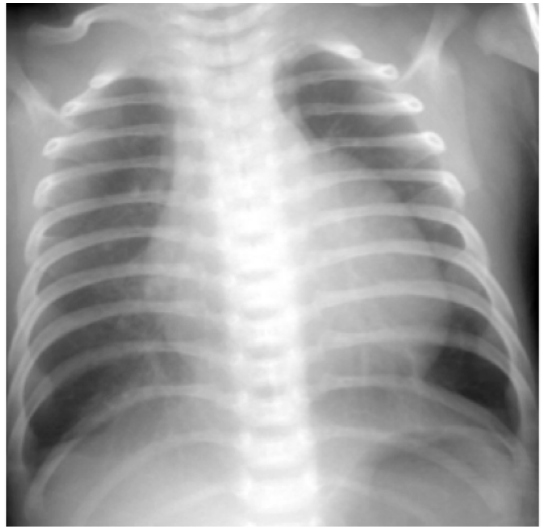
Figure 2. Chest radiography of a 52-day-old full-term male infant presenting with cyanosis and diagnosed with pulmonary hypertension showed bilateral hyperlucent lung and cardiomegaly with a cardiothoracic ratio of